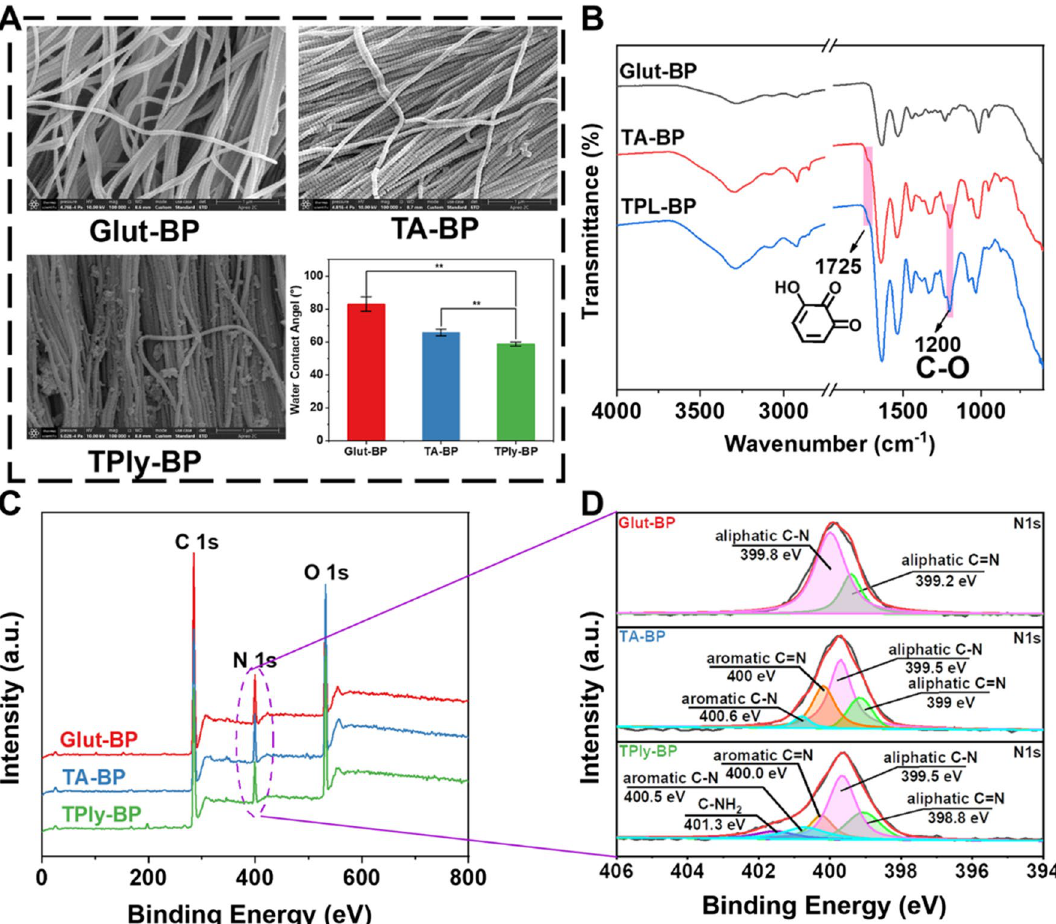
Fig. 1 Characterization of TPly-BP. A Typical SEM images, B ATR-FTIR and C wide scan XPS spectra of Glut-BP, TA-BP and TPly-BP. D High-resolution